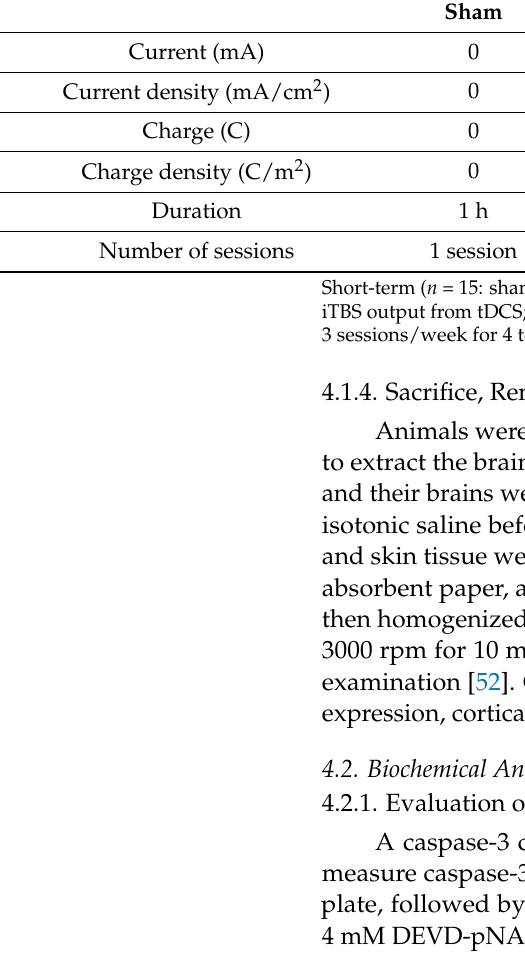
Table 2. Stimulation parameters for short- and long-term stimulations (tDCS-iTBS) ( n = 31).